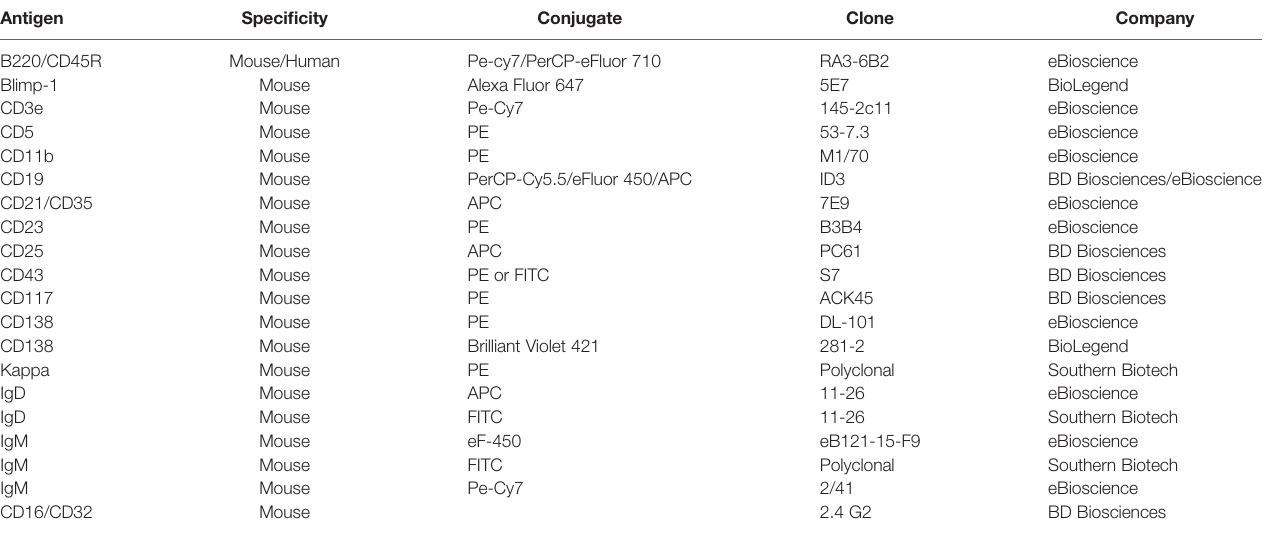
TABLE 3 | Antibodies used for fl ow cytometry.